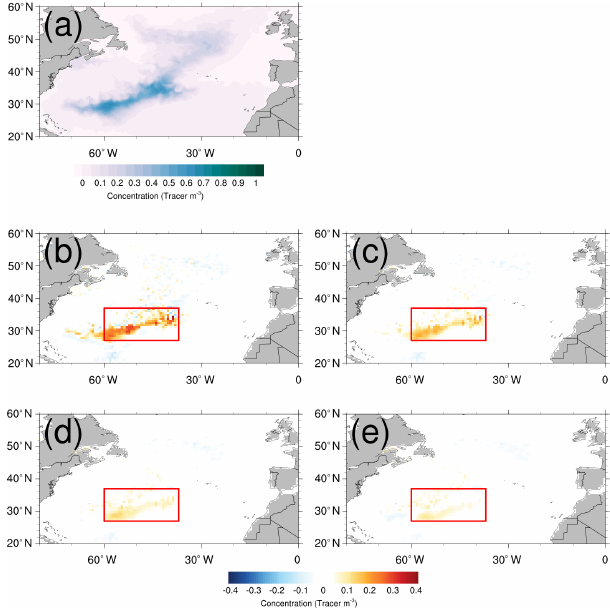
Figure A1. Surface values of the patch tracer after 1 year for the HR configuration (a) ; differences between HRCRS and HR con- figurations with diffusion equal to 300m 2 s − 1 (b) , diffusion equal to 600m 2 s − 1 (c) , diffusion equal to 900m 2 s − 1 (d) and diffusion equal to 1200m 2 s − 1 (e)